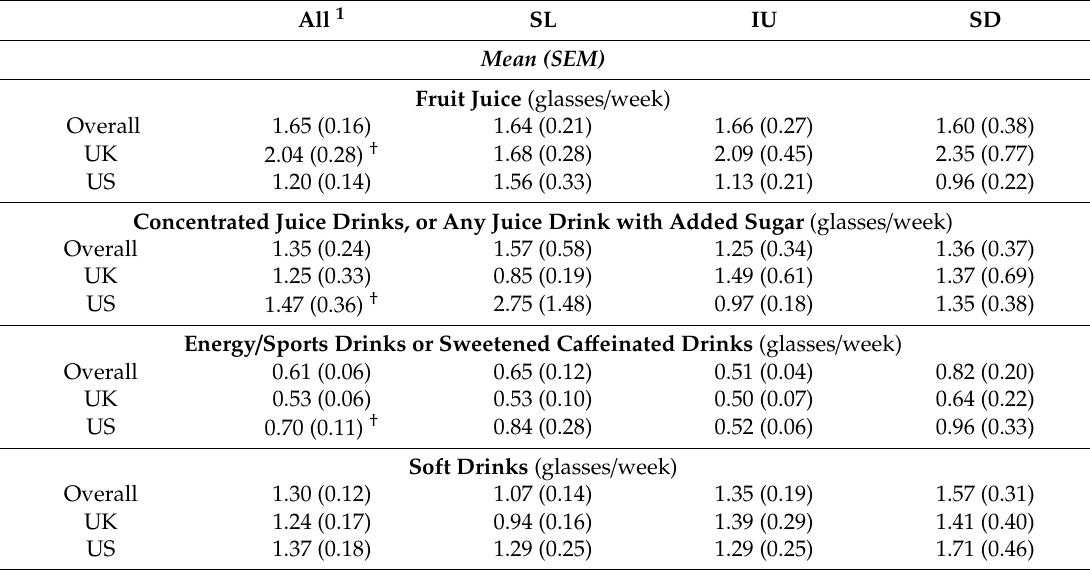
Table 2. Food frequency data by phenotype and by